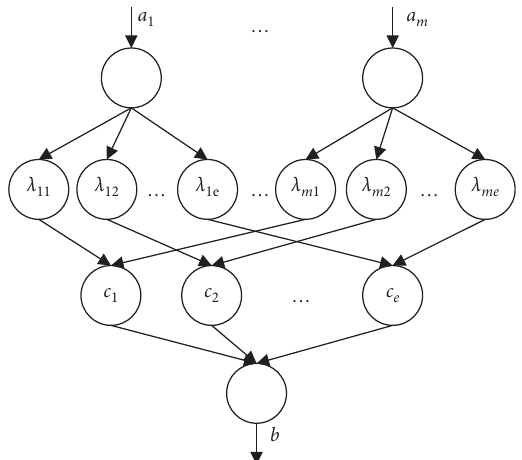
Figure 5: Structure of the proposed basic prediction neural